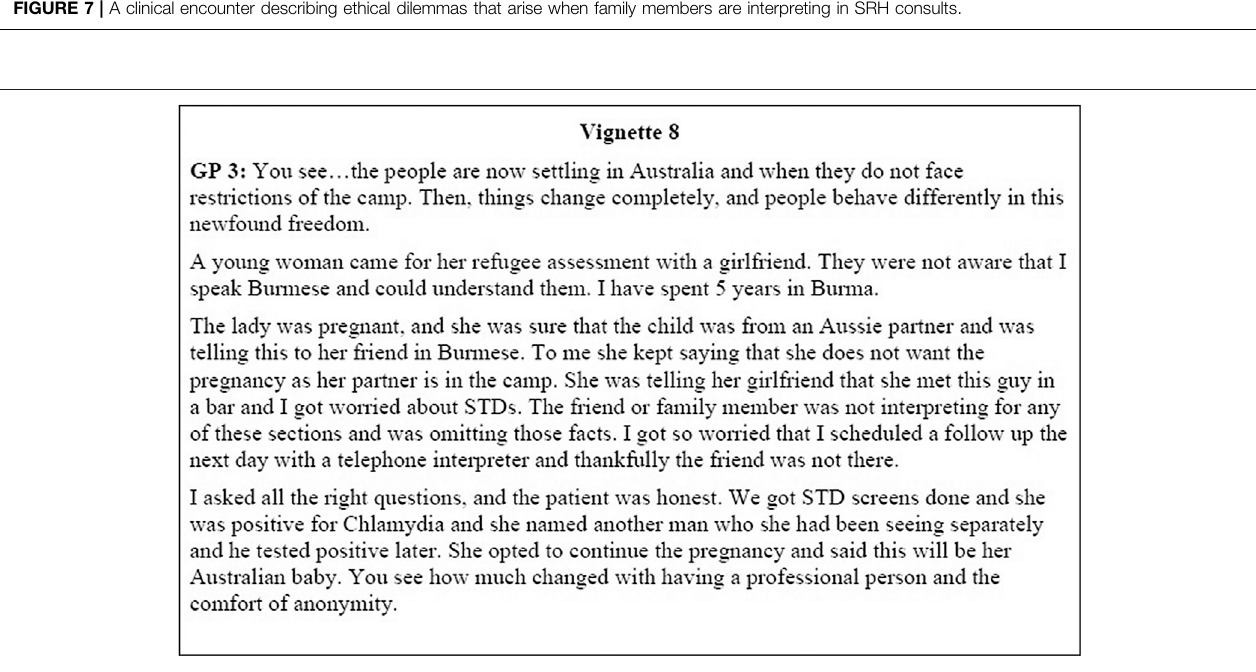
FIGURE 8 | Family members interpreting in SRH consults may choose to omit vital clinical information.